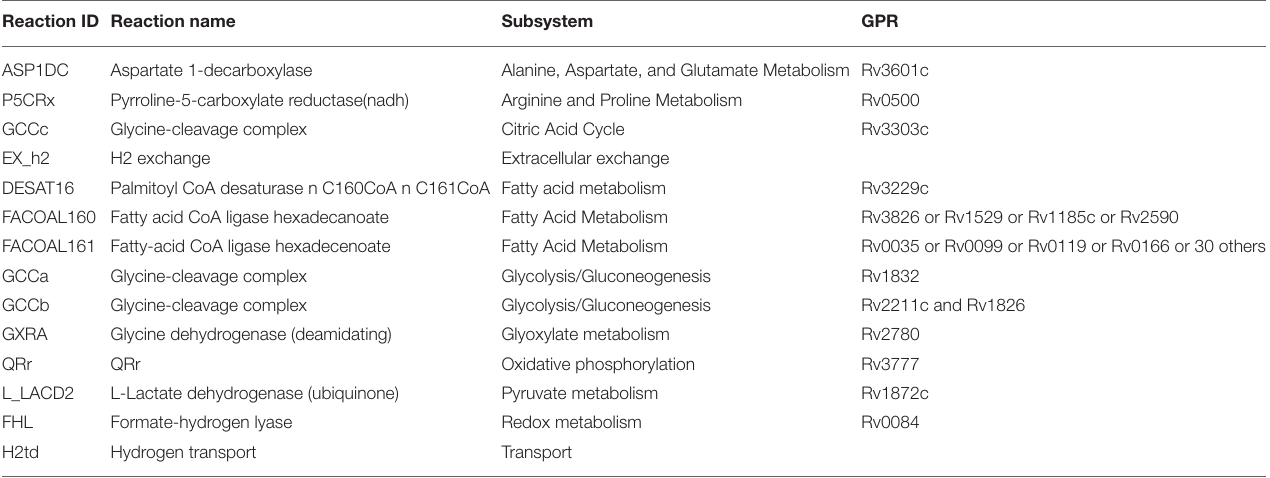
TABLE 2 | Reactions commonly upregulated in 3 or more dormancy